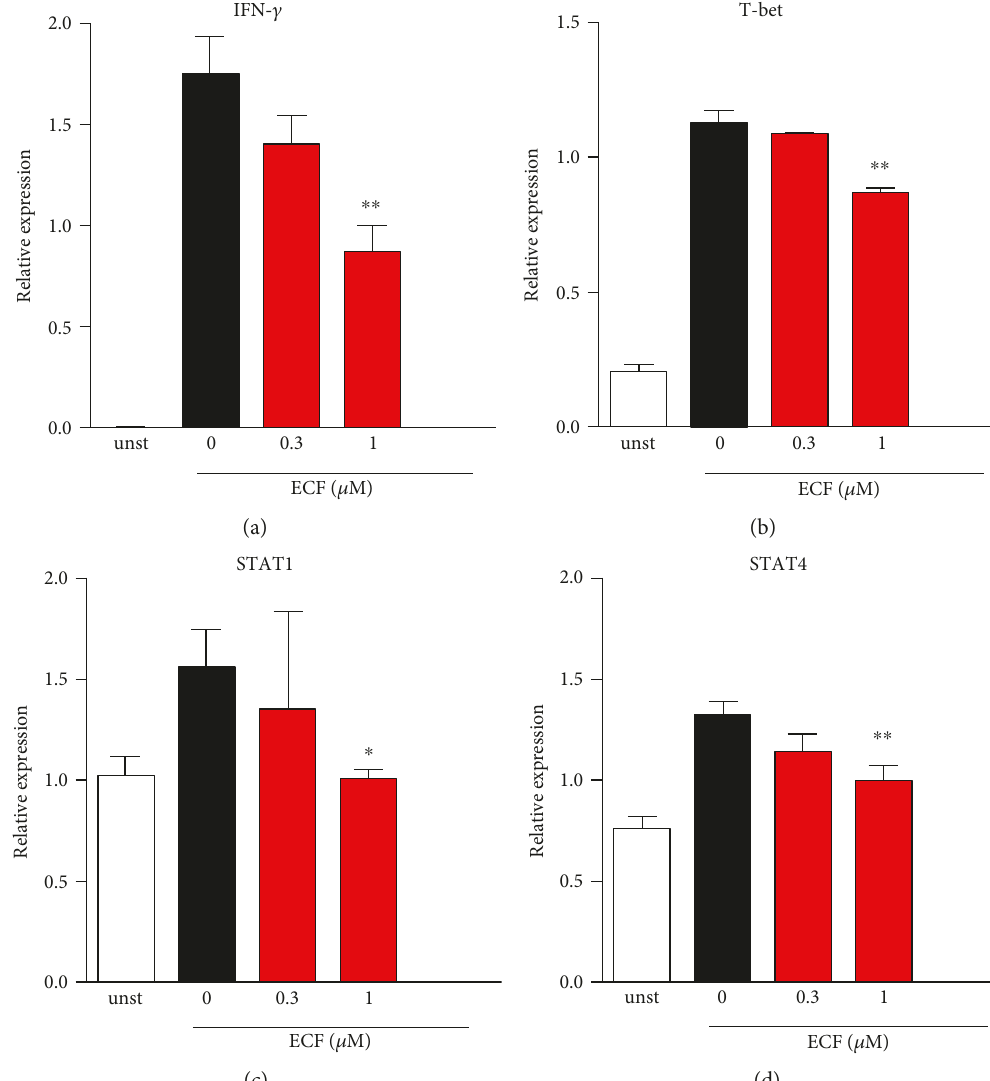
Figure 7: ECF suppresses IFN- γ -related pathway in TCR engagement-mediated T lymphocyte activation. Puri fi ed CD4 + T cells were stimulated with anti-CD3 (5 μ g/ml) and anti-CD28 (2 μ g/ml) for 16 h. Total RNA was isolated using RNeasy kits, and 1 μ g of total RNA was used to synthesis cDNA. Real-time quantitative PCR assay was carried out using SYBR Premix Ex Taq II kit, and relative quanti fi cation of mRNA expression was calculated as the fold increase using the delta-delta Ct; the housekeeping gene is β -actin. Results presented are mean ± s.e.m., n = 3 . ∗ P < 0 05 , ∗∗ P < 0 01 versus vehicle